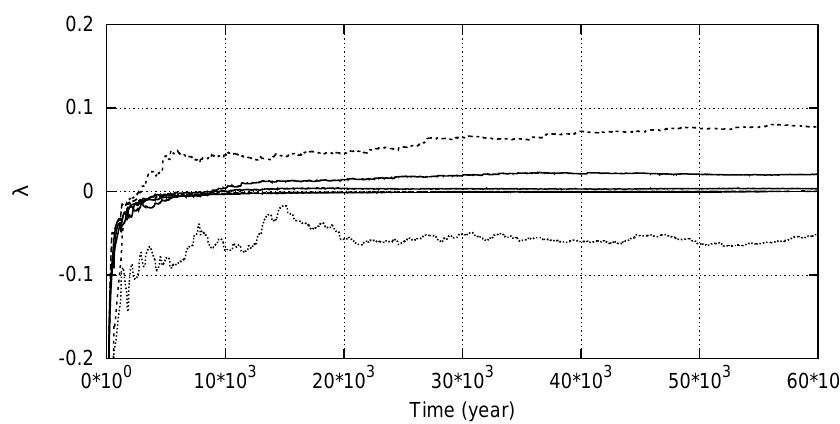
Fig. 2. Lyapunov exponents for all phase-space coordinates for one of the